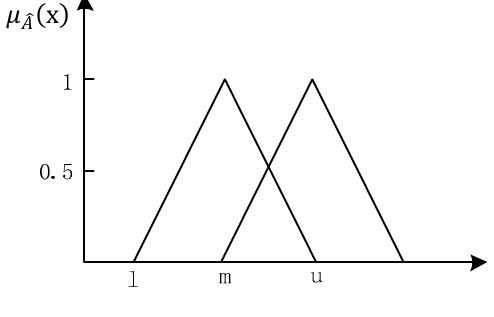
Figure 2. Definition of triangular fuzzy number.